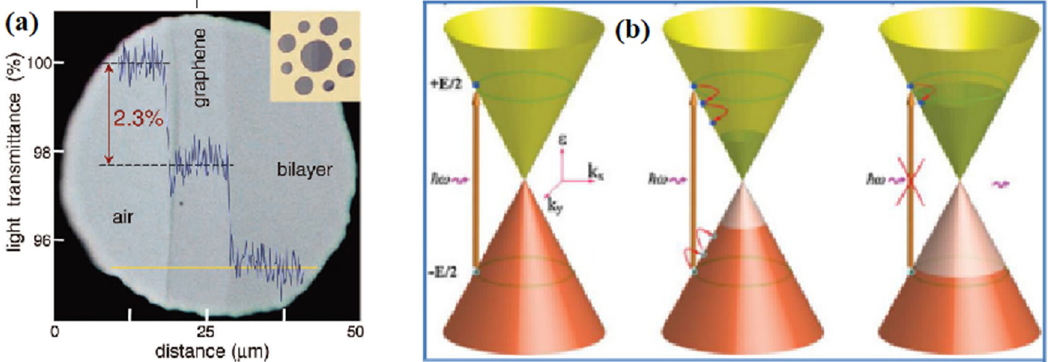
Figure 4: ( a ) Absorption rate of mono - and bilayer graphene in the presence of light and ( b ) the dynamic simulation of graphene - saturated absorption [ 73 ]